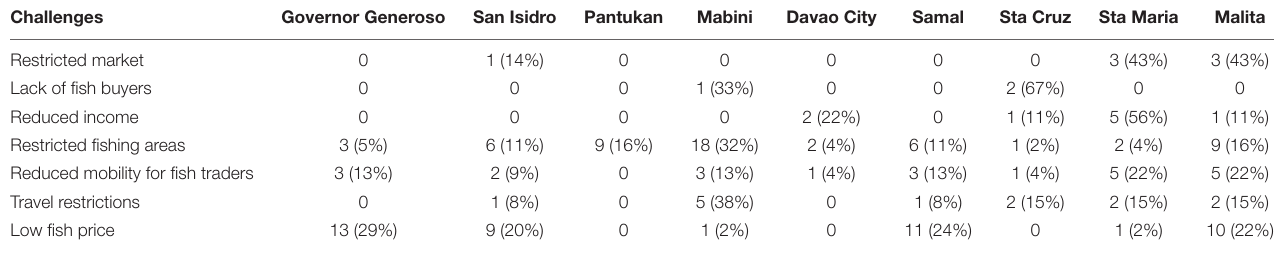
TABLE 4 | Cross-tabulation of challenges experienced by fishers during COVID-19 pandemic.